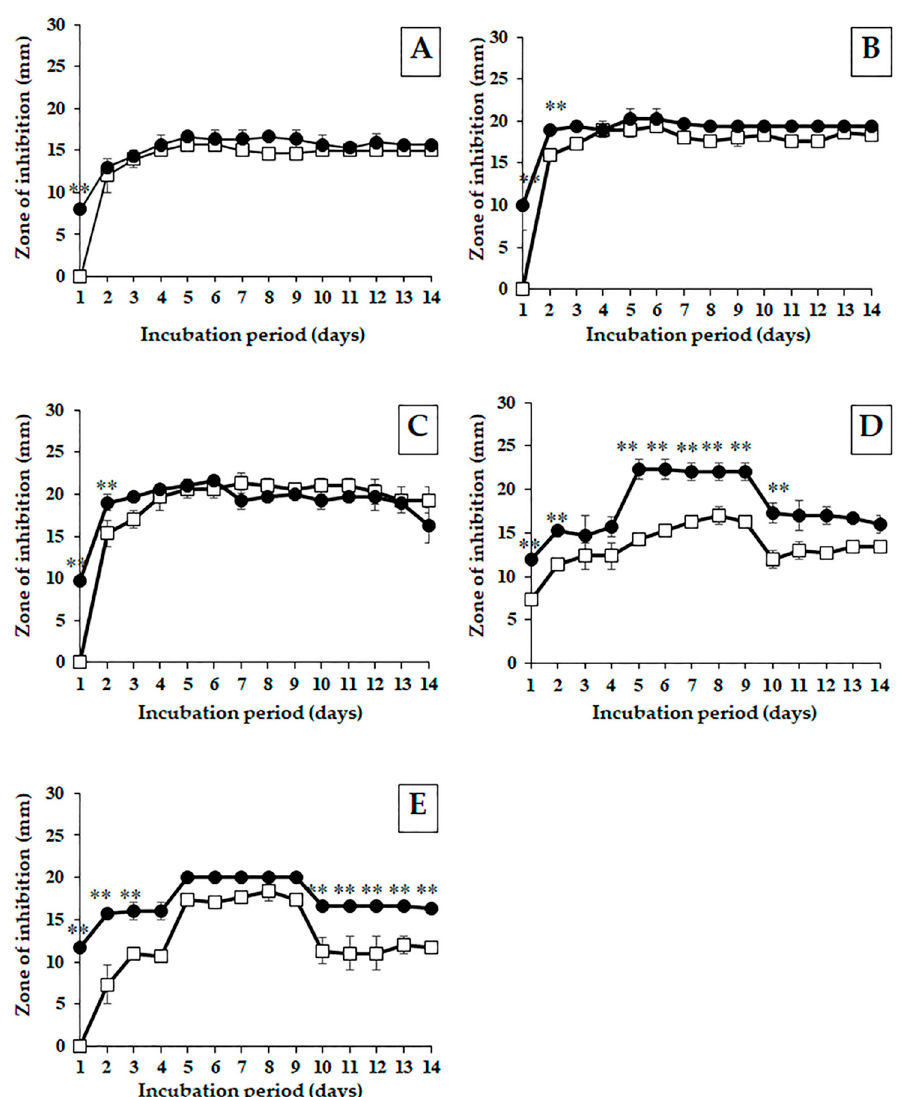
Figure 3. Effect of incubation temperature on the activity of antibacterial agents of Streptomyces sp. PJ85 cultured in ISP-2 medium against ( A ) MRSA DMST20651, ( B ) S. aureus ATCC29213, ( C ) S. epidermidis TISTR518, ( D ) B. subtilis TISTR008, and ( E ) B. cereus TISTR687. Incubation temperatures: